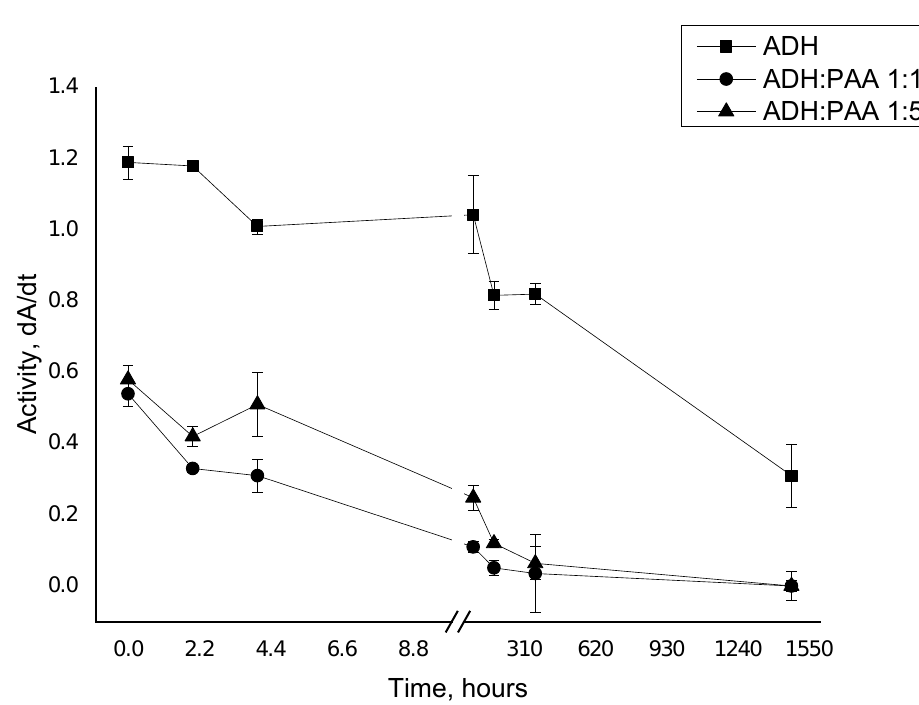
Figure 1. The dependence of the activity of ADH (alcohol dehydrogenase) (6.25 µ g / ml) in the native state and in the presence of PAA (6.25 µ g / ml, 1:1; 31.25 µ g / ml, 1:5) from the time of incubation.